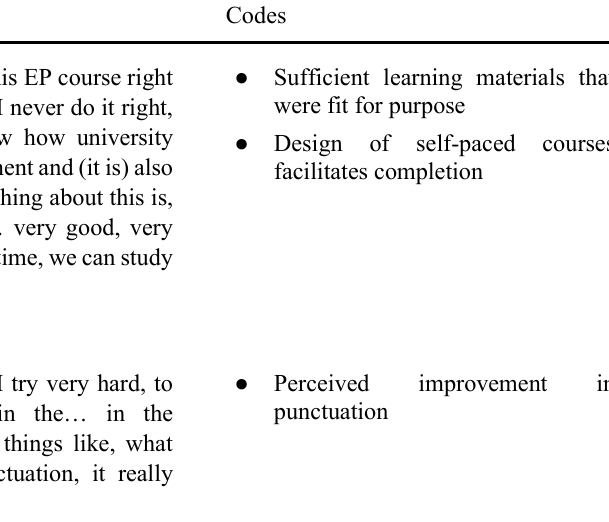
Figure 2. Example of coded interview transcript.